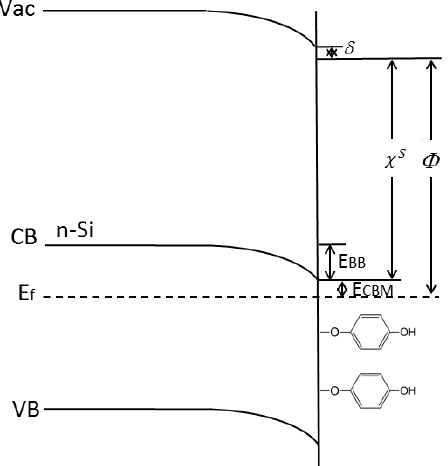
Figure 9. Electronic structure of BQ passivated n-Si surfaces. Both the negative dipole δ and the downward band bending 𝐸 𝐵𝐵 contribute to the decrease of the Si surface work function upon bonding of BQ radicals.